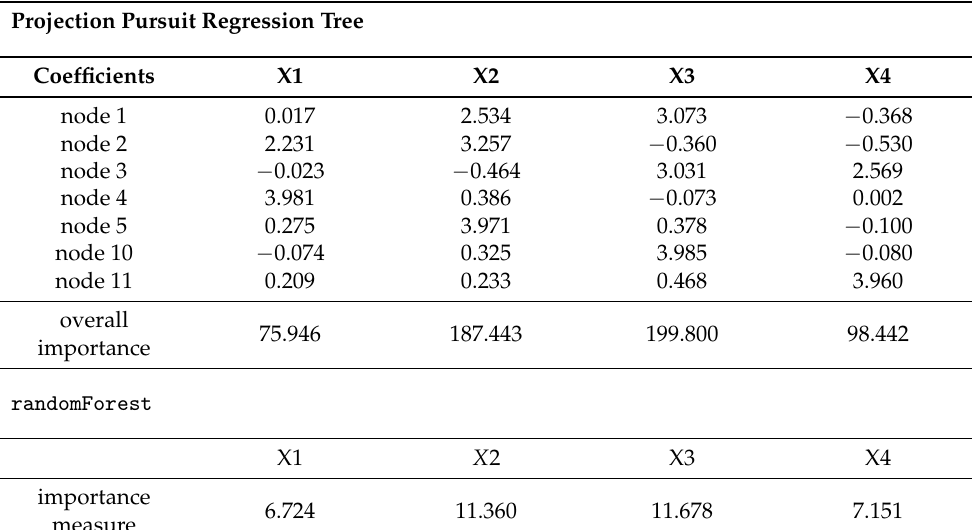
Table 2. The projection coefficients of each node in the projection pursuit regression tree and the importance measure of randomForest .